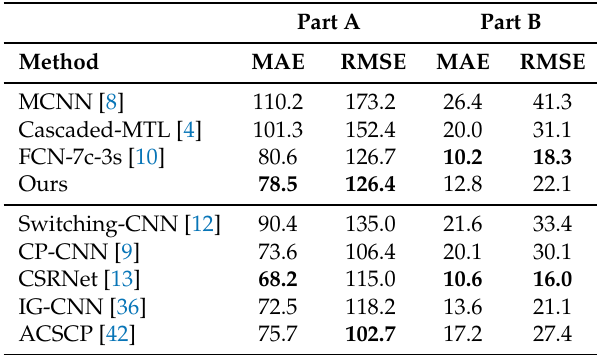
Figure 5. Density estimation results on ShanghaiTech Part B [8]. ( a ) Input images, ( b ) ground truth density maps, and ( c ) estimation results. Table 4. Comparison of networks on the ShanghaiTech